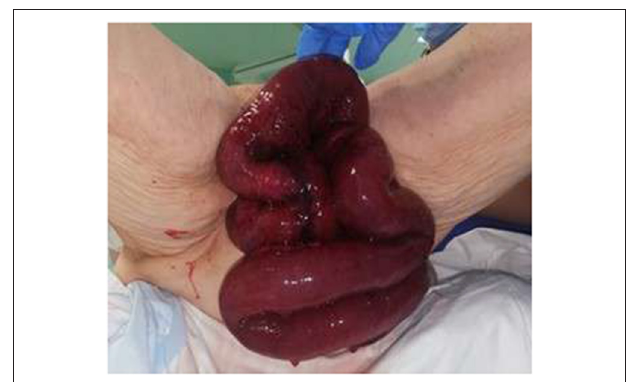
FIGURE 1 | Necrotic ileal loops eviscerated from the vagina.